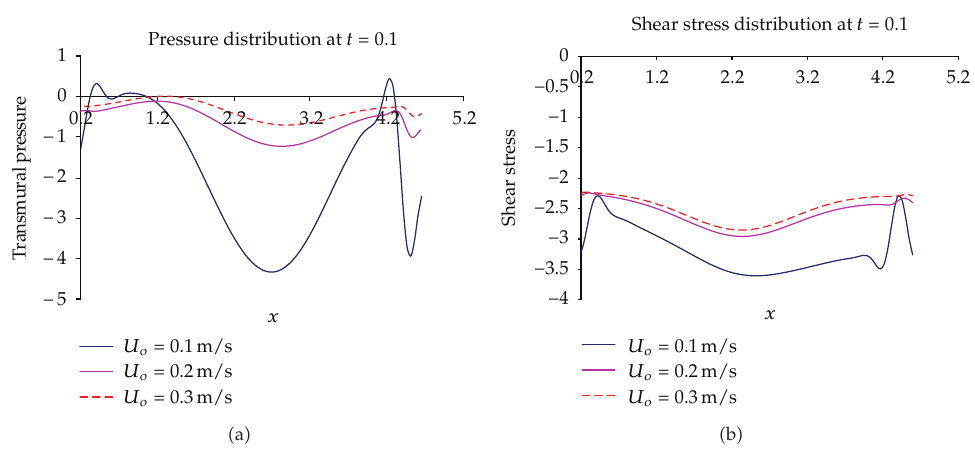
Figure 5: Intramural pressure distribution (cid:3) a (cid:4) , and wall shear stress distribution (cid:3) b (cid:4) for inlet velocity U o (cid:7) 0.1m/s, 0.2m/s, 0.3m/s.